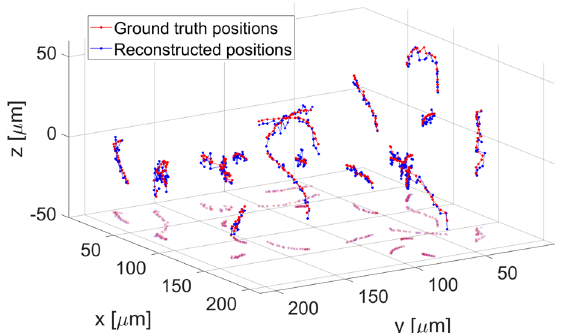
Figure 3. 4D particle tracking reconstruction provided by DarkTrack for 20 holograms sequence (starting from Fig.